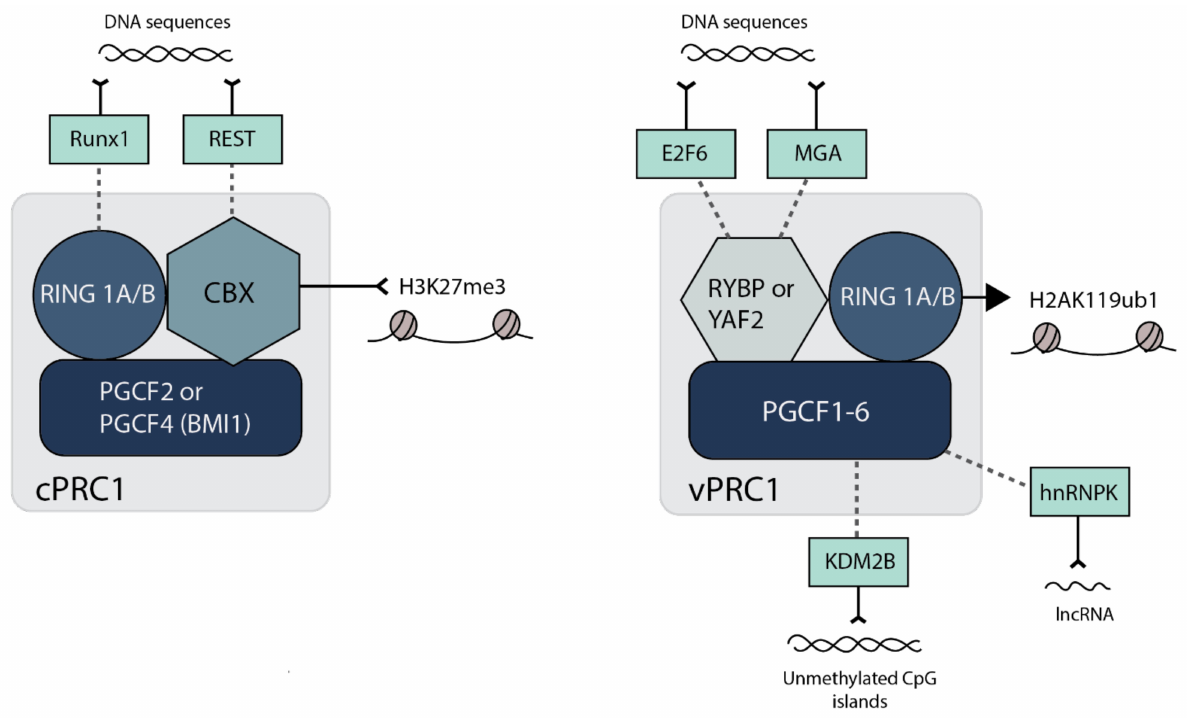
Figure 2. The components of canonical and variant PRC1 complexes and interacting transcription factors. Canonical PRC1 (cPRC1) consists of one of two PGCF proteins (PGCF2 or PGCF4), along with RING1A/B and one of five chromobox (CBX) proteins. Although catalytically active, cPRC1 is thought not to contribute to the majority of H2AK119ub1. CBX proteins directly bind to H3K27me3, so cPRC1 recruitment to chromatin is dependent on PRC2 H3K27 methylation activity. Variant PRC1 (vPRC1) contains any of the six PGCF proteins, RING1A/B, and RYBP or YAF2. RYBP/YAF2 do not bind H3K27me3 and vPRC1 recruitment is thus independent of PRC2 activity. RYBP stimulates RING1A/B activity, and vPRC1 writes H2AK119ub1. Transcription factors RUNX1 and REST can interact with cPRC1 via RING1B and CBX7/8, respectively, recruiting the complex to specific target sequences of DNA. E2F6 and MGA can similarly recruit vPRC1 to specific DNA sequences by interaction with RYBP/YAF2, while hnRNPK can do so through interaction with PGCF3/5 and long-noncoding lncRNA. KDM2B can recruit vPRC1 to non-sequence specific, unmethylated CpG